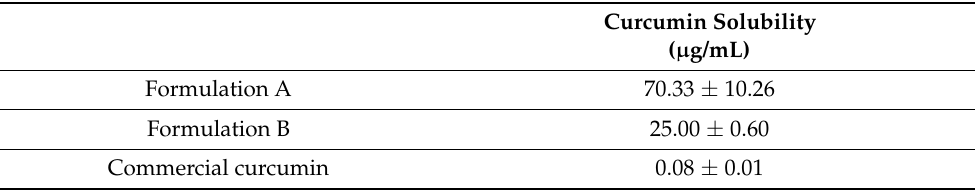
Table 2. Saturation solubility of curcumin from Formulation A, Formulation B and commercial curcumin in pH 6.8 buffer ( n = 3, mean ±